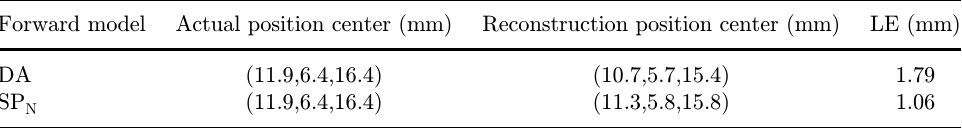
Table 5. Results in single target case on the ¯nal mesh (highly absorbing media).